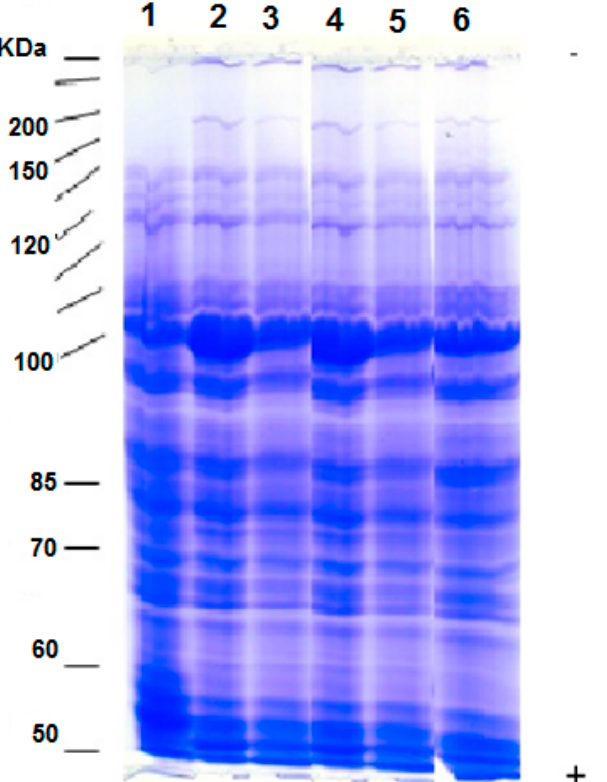
Figure 5. Analysis of protein patterns by one dimensional SDS-PAGE (13.5% gel) extracted from wheat plants, showing the changes of protein bands, in response to salinity (150 mM NaCl) and 1% conc. ( H. cuneiformis and A. fragilis extracts ) treatments. Each lane contains equal amounts of protein. Protein bands in the gel were visualized by a modified Coomassie Blue staining. Lane (M): Protein markers, Lane (2): Plants treated with H. cuneiformis , Lane (3): Plants treated with A. fragilis , Lane (4): Plants treated with NaCl, Lane (5): Plants treated with NaCl + H. cuneiformis and Lane (6): Plants treated with NaCl + A fragilis .